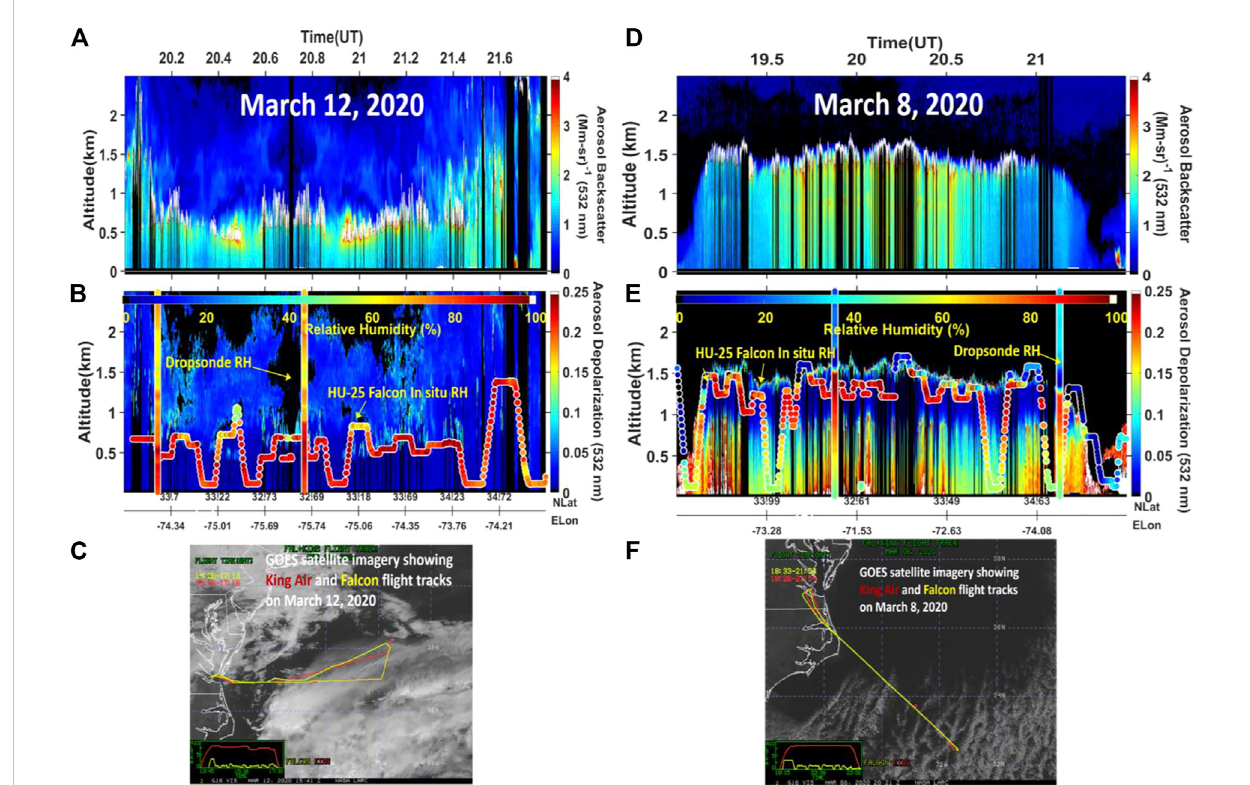
FIGURE 1 Pro fi les of (A) particulate backscatter and (B) particulate depolarization (532 nm) measured at 532 nm by HSRL-2 on 12 March 2020, with the corresponding color bars on the right. Also shown in (B) are in situ measurements of RH acquired from in situ measurements on the Falcon aircraft and dropsondesdeployedfromtheKingAiraircraftwiththecorrespondingcolorbaratthetop.Imagesareat10 s(~1 km)resolution.Cloudyareasareshown by the white areas in the backscatter images. Thick clouds completely attenuate the laser light leading to black stripes below these clouds. (C) Ground tracks of the King Air and Falcon aircraft are shown on GOES imagery. (D – F) show similar images of HSRL-2, airborne in situ, and dropsonde measurements and aircraft fl ight tracks for 8 March 2020. Note the pronounced increase in particulate depolarization on 8 March